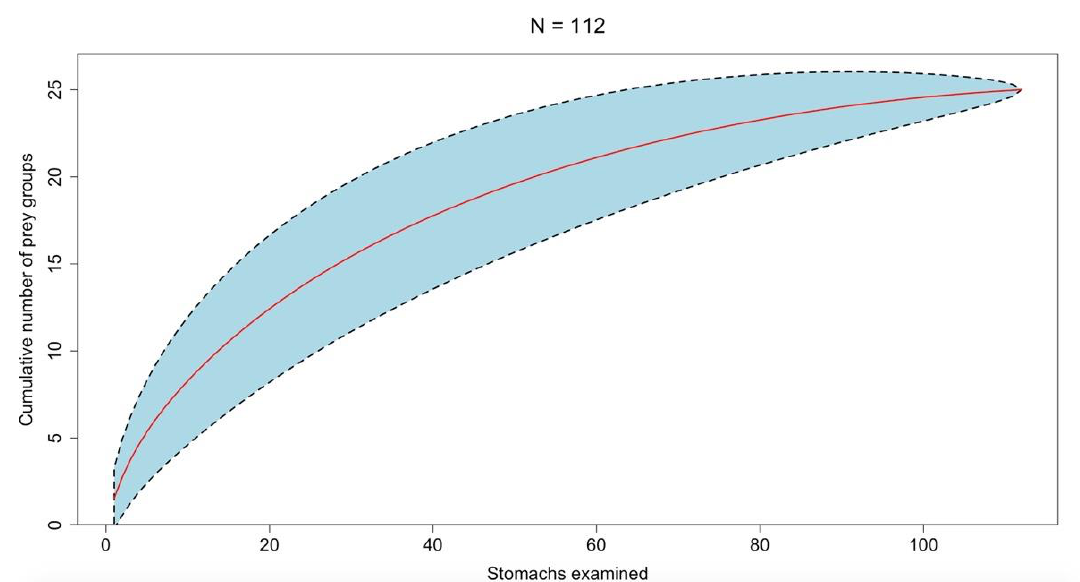
Figure 5. Cumulative prey curve (in red) as a function of sample size for all stomachs of G. melastomus analysed. The standard deviation (SD) is represented with dashed lines.